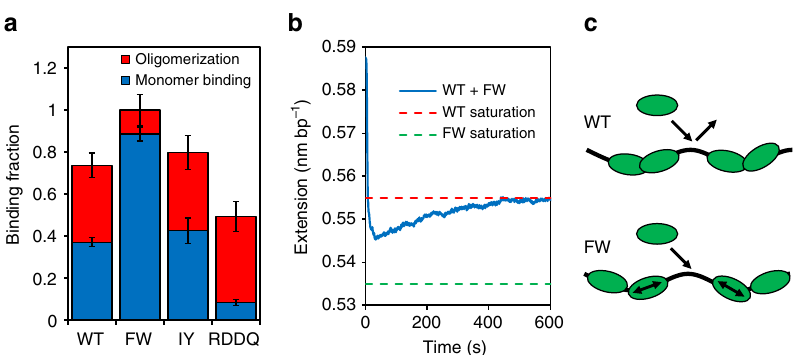
Fig. 6 Effects of A3G oligomerization on saturated binding. a Average quantities of A3G binding due to fast initial binding ( blue ) and slow oligomerization ( red ) for WT A3G and the three mutants. Values are based on A fast and A slow obtained from fi tting two state binding model. Binding amplitudes are normalized based on total binding by FW mutant at saturation. Error bars are SEM for at least three measurements. b Measured extension of ssDNA due to simultaneous binding of both 50 nM WT and FW A3G. The initial binding occurs at a faster rate than that due to either 50 nM WT or FW alone and results in an extension change in between that due to either WT or FW binding alone. Over time, the extension change decreases as more stably bound WT A3G replaces the more transient FW A3G. c Schematic showing how the formation of A3G oligomers with reduced mobility can prevent full saturated binding of ssDNA substrate. This effect is observed for both WT A3G and the CTD mutants. In contrast, for the NTD (FW) mutant, bound A3G remains in a monomer state for a signi fi cantly longer period of time and is able to saturate all binding sites through restricted diffusion before forming oligomers. This model is consistent with previous measurements showing altered sliding and jumping of FW mutant A3G as compared to WT 22